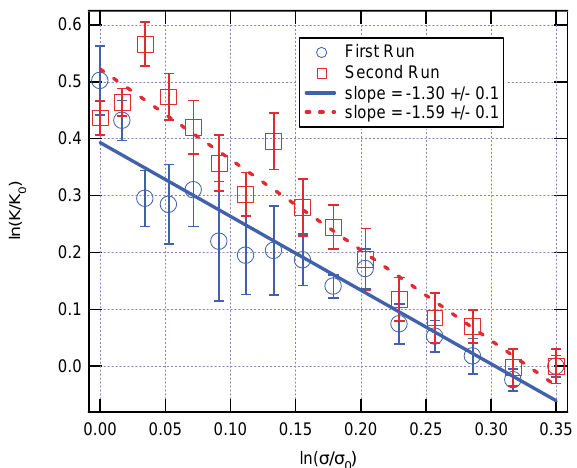
FIG. 7. (Color) Normalized parasitic mode losses determined from current scans at different rf cavity voltages in two different runs. The slopes give the impedance model parameter a . We have used rf voltages ranging from 216 to 426